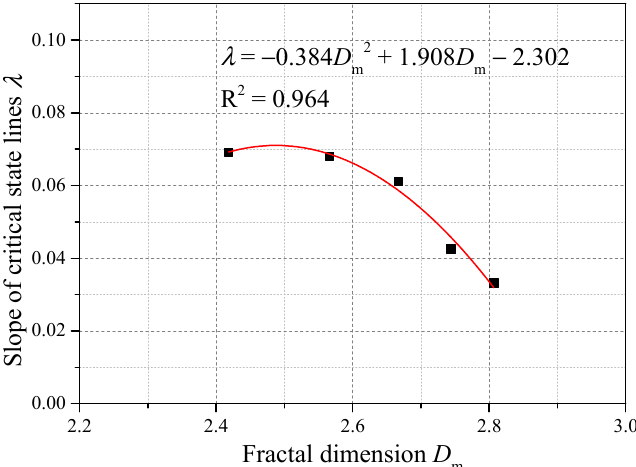
Figure 10. Relationship between slope of critical state lines λ and fractal dimension D m .